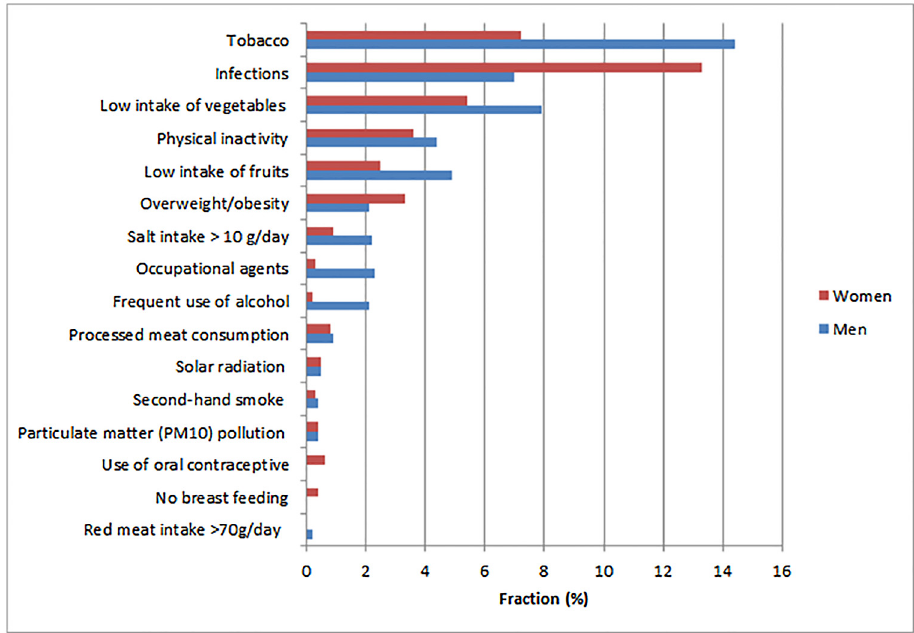
Fig 1. Estimated fraction of the total cases of cancer for the population 30 years old and over in Brazil attributable to selected risk factors in 2020.